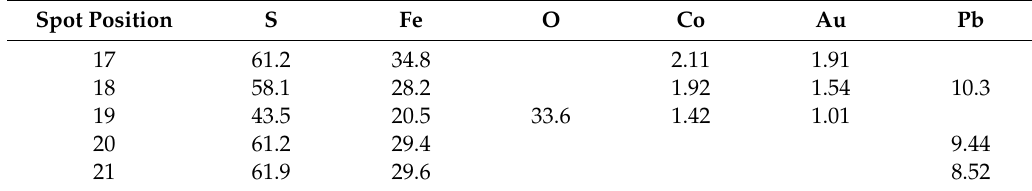
Table 3. SEM-EDS analyses (wt.%) for fine pyrite grain (Figure 5b) on the ore